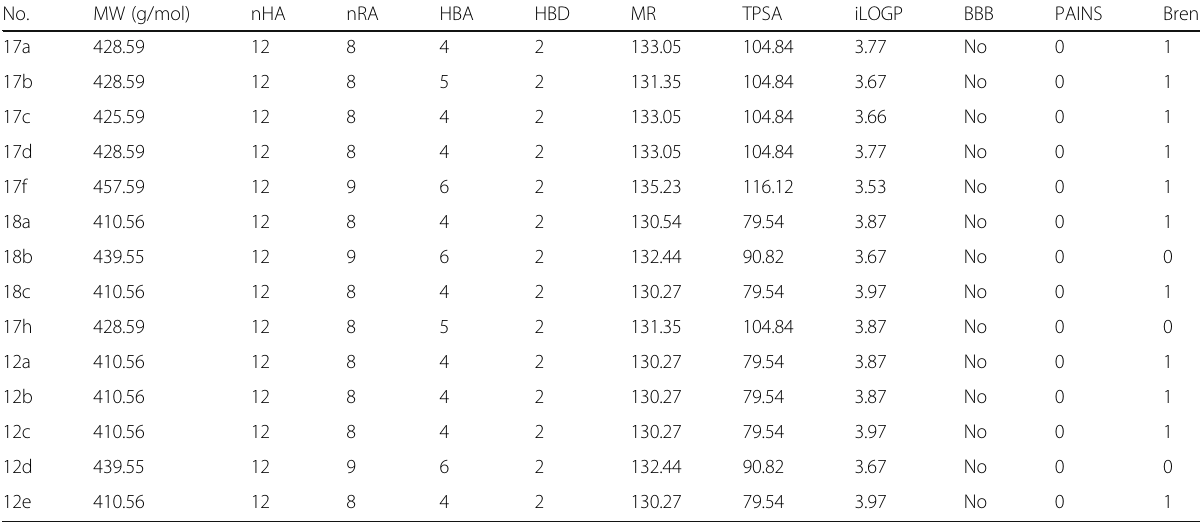
Table 4 Pharmacokinetic properties of the newly designed 2-anilinopyrimidine compounds against MDA-MB-468 cell line No.